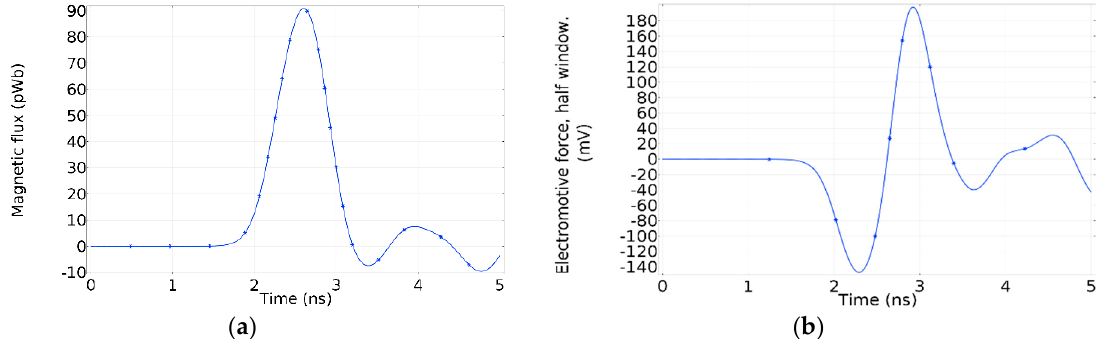
Figure 7. ( a ) Magnetic flux through half-window; ( b ) electromotive force induced in half-window.